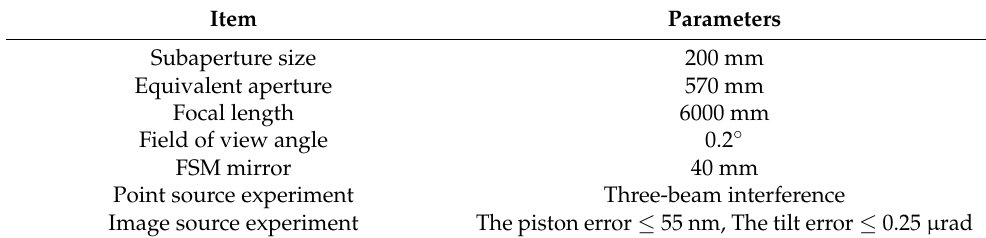
Table 1. Main system parameters and experimental